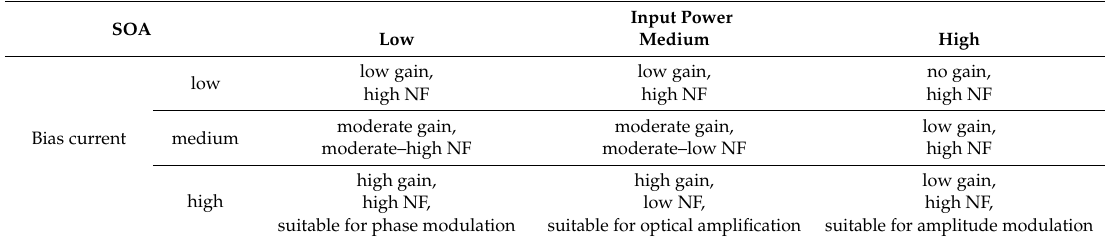
Table 2. Areas of operation for an SOA and its exploited performance for their application. SOA